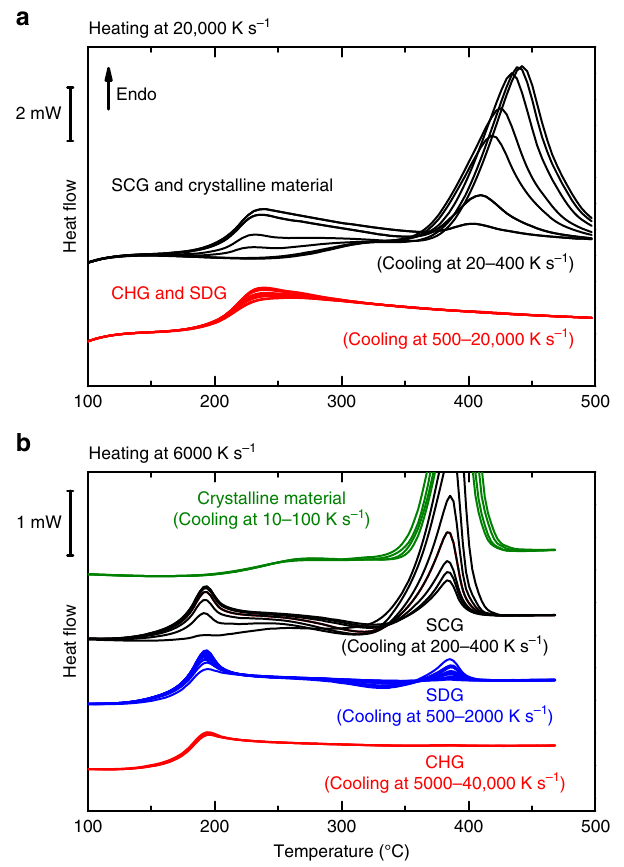
Fig. 4 Separation of different types of glasses. a Heating curves measured at 20,000K s − 1 for differently cooled samples between 20 and 400 K s − 1 (black) and 500 and 20,000 K s − 1 (red). b Heating curves measured at 6000 K s − 1 for differently cooled samples between 10 and 40,000K s − 1